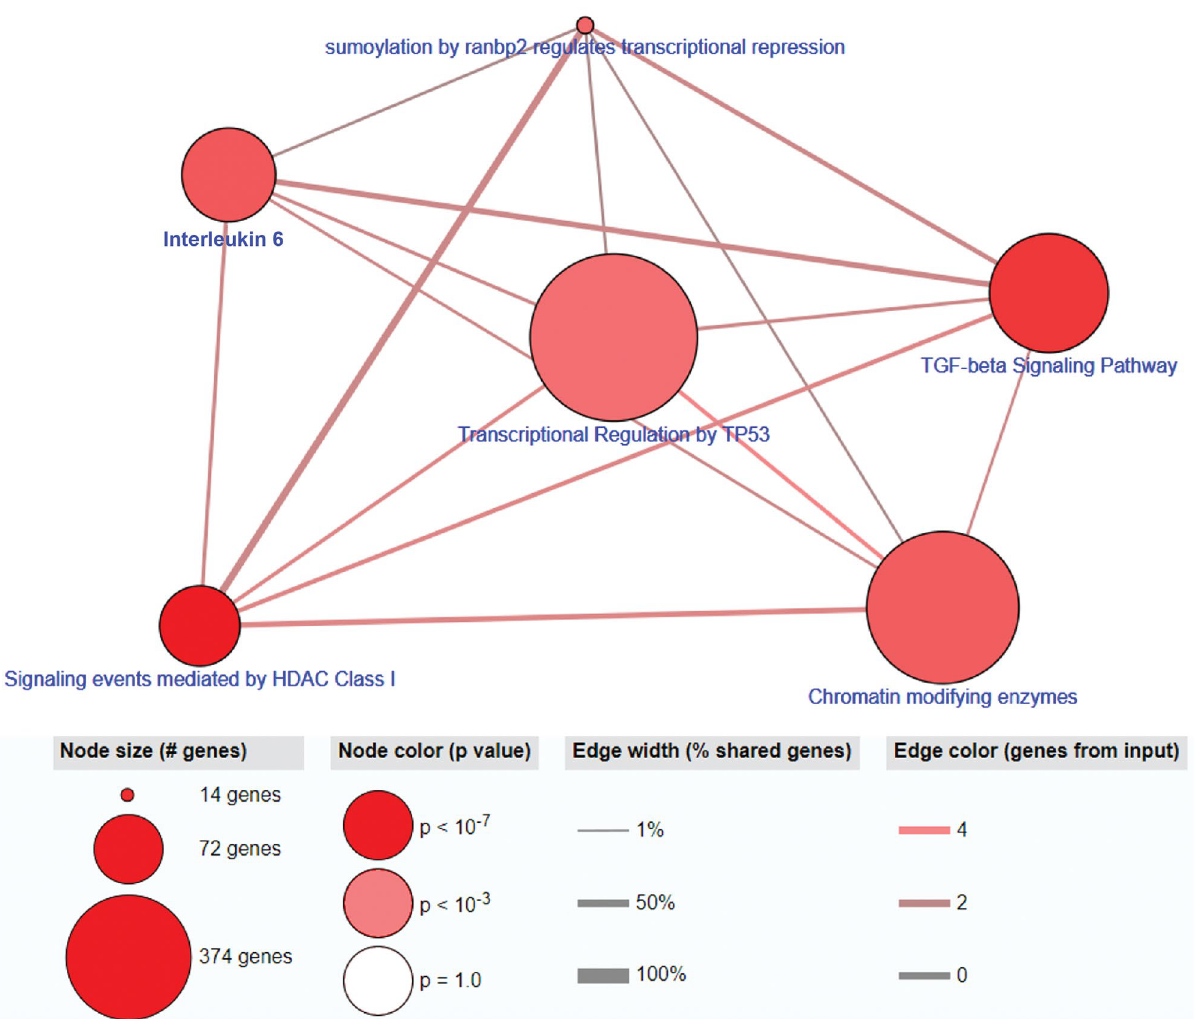
Figure 2. Relationship between top identified pathways associated with ARDS mortality using the Network approach and ConsensusPathDB 26